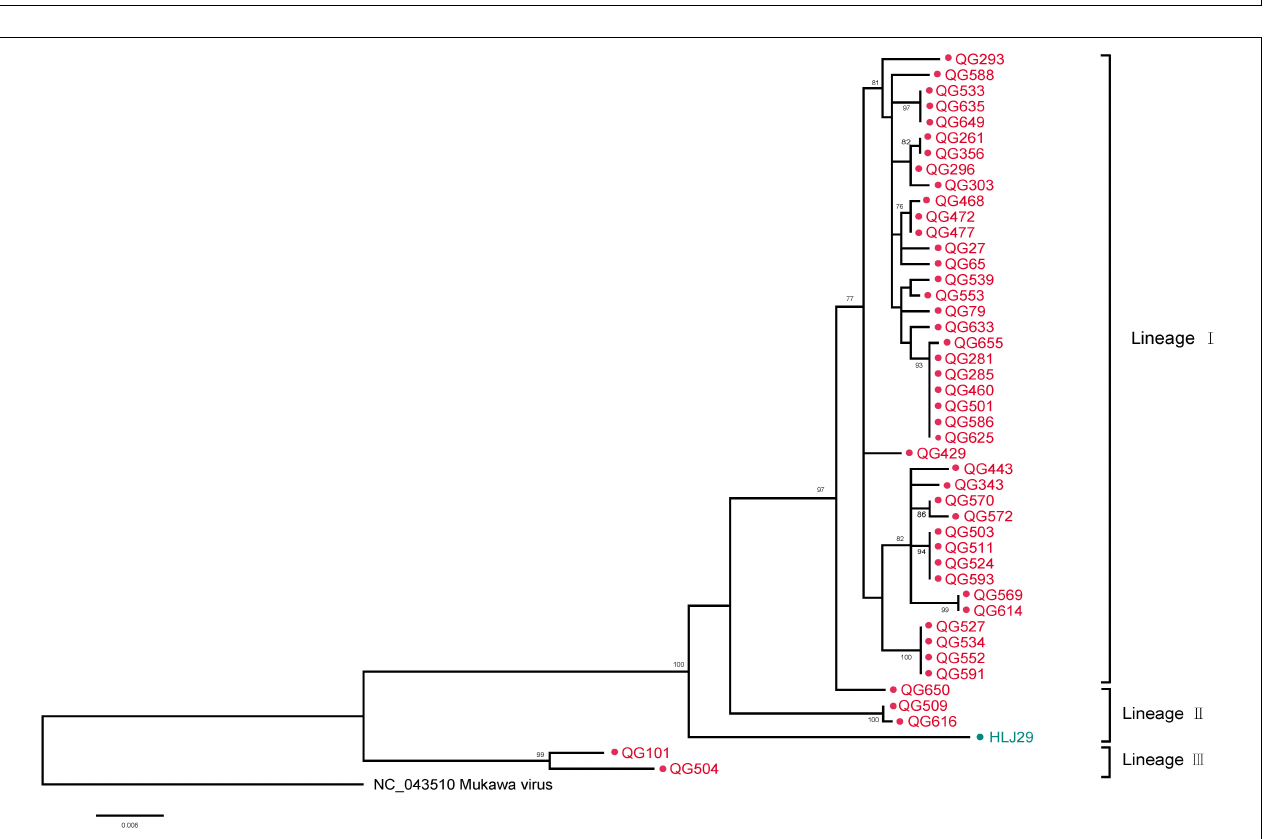
FIGURE 5 | Phylogenetic analysis of 895-bp MKWV-positive RNA sequences. The Maximum likelihood phylogenetic tree constructed based on the 895-bp MKWV-positive RNA sequences ( n = 46) of the L segment. The MKWV-positive RNA sequences from I. persulcatus were labeled with red solid dots, and the MKWV-positive RNA sequences from H. concinna were labeled with green solid dots. Trees that were generated using MEGA-X and analyzed included 1,000 bootstrap replicates.